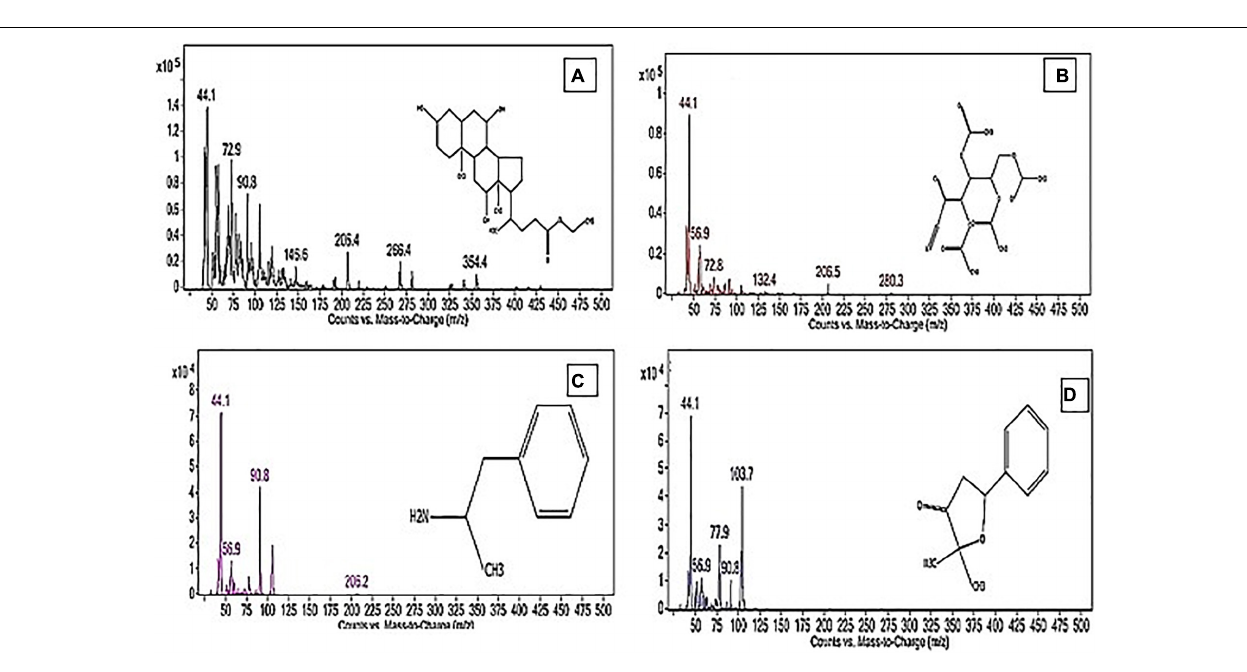
FIGURE 8 | The structure of the principal chemicals found in Pleurotus ostreatus polar extract was revealed by the GC-MS chromatogram (A) Ethyl iso-allocholate, (B) Tetraacetyl-D-xylonic nitrile, (C) Amphetamine, and (D) 3(2H)-Furanone, dihydro-2,2-dimethyl-5-phenyl. The Supplementary Figure 1 has mass fragmentation patterns for the other detected chemicals that reported in Table 7